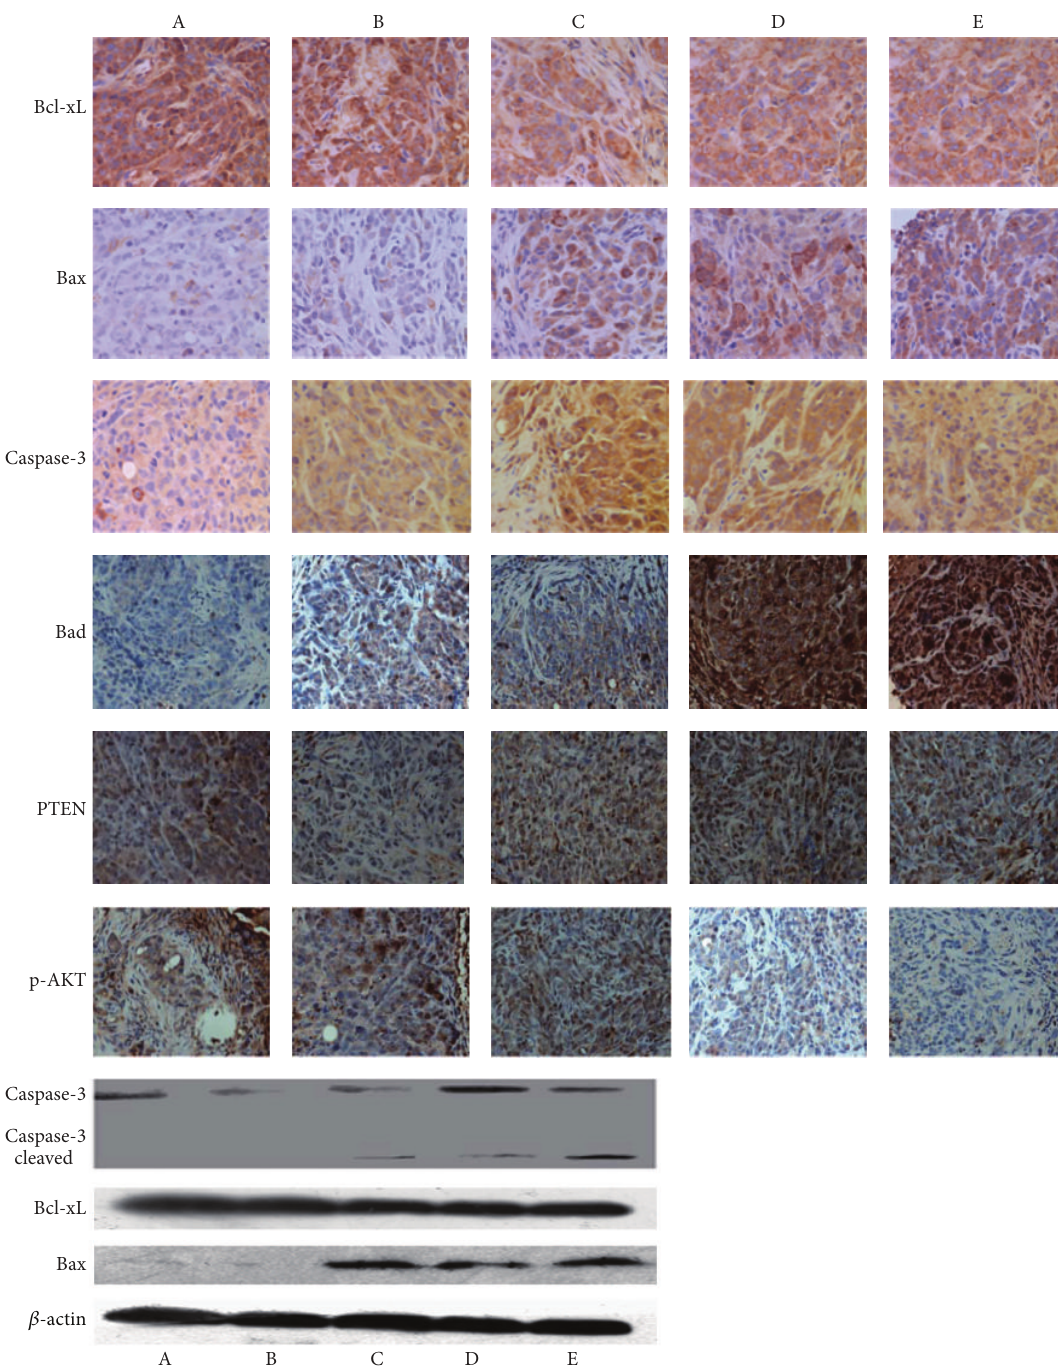
Figure 5: Immunohistochemical staining of Bcl-xL, Bax, Caspase-3, Bad, PTEN, pAKT, and Western blot test on selected proteins (Caspase- 3/cleaved, Bcl-XL, and Bax). Upper: immunohistochemical staining ( × 400). Left: Western blot. Groups: A: NS, B: 5-FU, C: 0.5 mg/kg, D: 1.0mg/kg, and E: